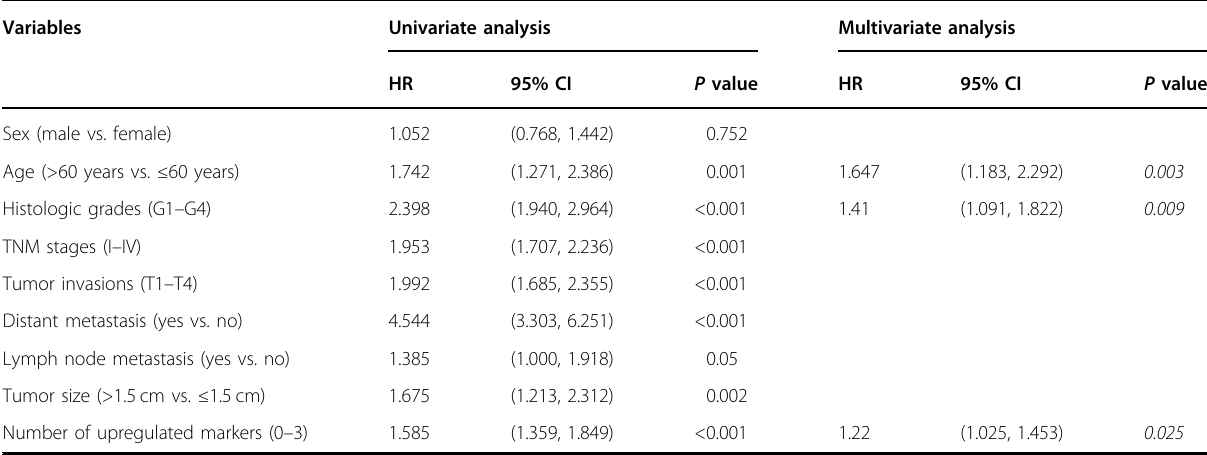
Table 1 Univariate and multivariate Cox regression analyses of upregulated marker number for overall survival in KIRC (TCGA